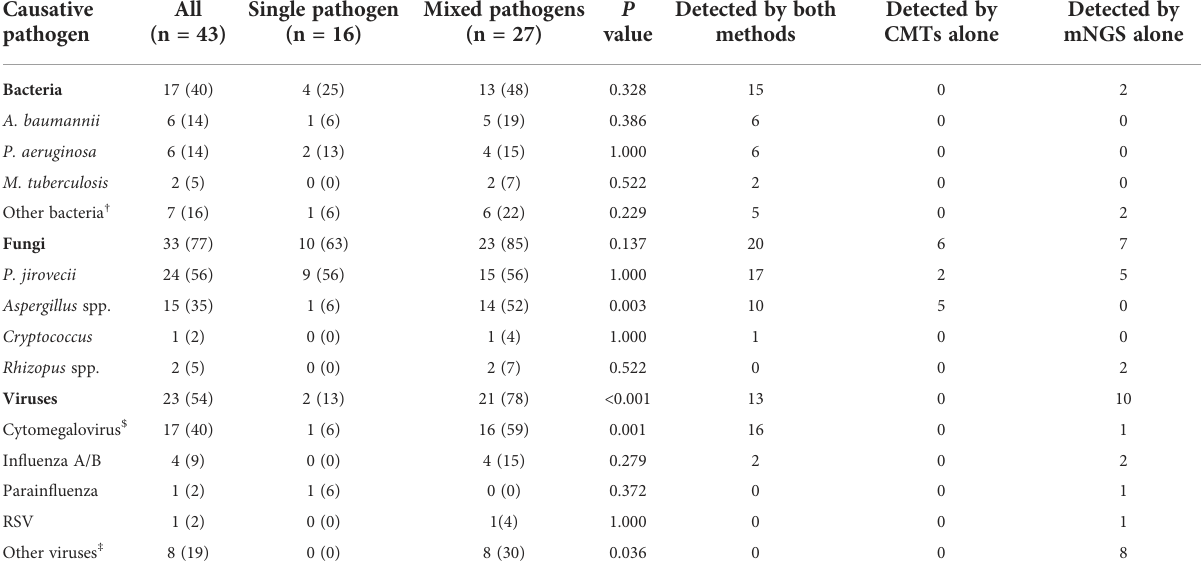
TABLE 2 Causative pathogen and divergent identi fi cations by mNGS and CMTs in 43 patients with microbiologically con fi rmed pneumonia. Causative All Single pathogen pathogen (n = 43) (n =